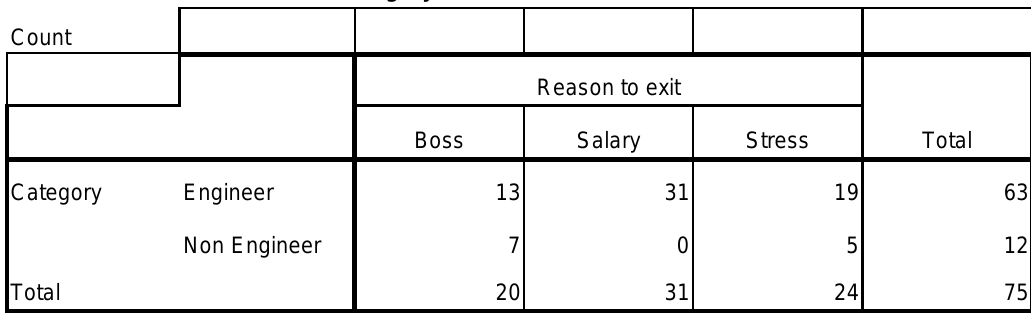
Table 2: Category * Reason to exit Cross tabulation